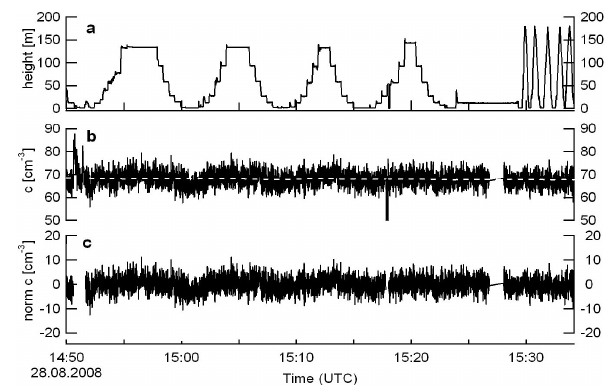
levels N data points per level 1/2 2/3